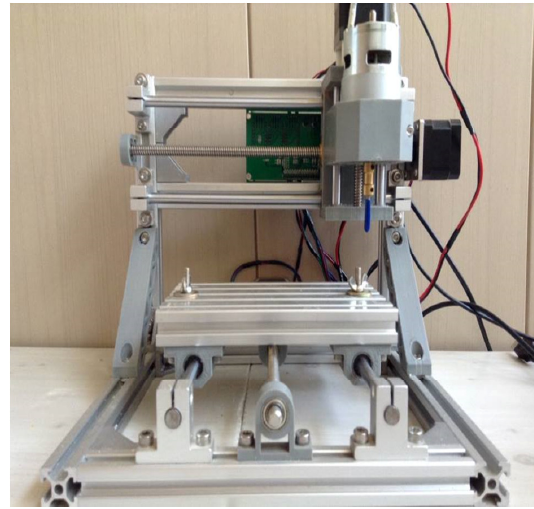
Fig. 4. CNC milling